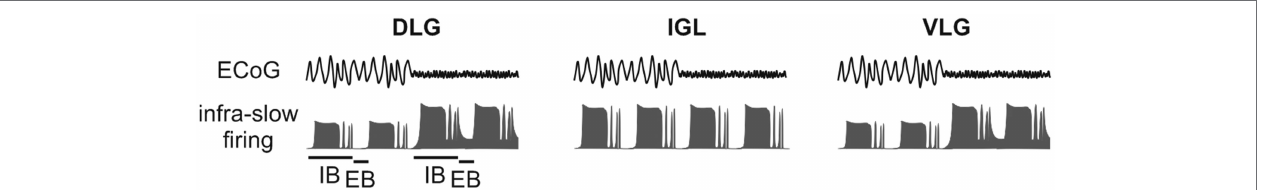
FIGURE 3 | Modulation of infra-slow and gamma oscillations in the lateral geniculate nucleus (LGN) by the general brain state. Simultaneous recording of the electrocorticogram (ECoG) and neuronal activity in the thalamic SVS shows an impact of general brain state on the infra-slow oscillatory pattern. High amplitude, low frequency delta rhythm in the ECoG represents ‘cortical deactivation’. Contrary, low amplitude, high frequency theta oscillation is evident in the ECoG during ‘cortical activation’. Note that general brain state enhances neuronal firing in the DLG and ventrolateral geniculate nucleus (VLG) during both the intra-burst (IB) and extra- burst (EB) phase of the infra-slow oscillation. IGL, intergeniculate